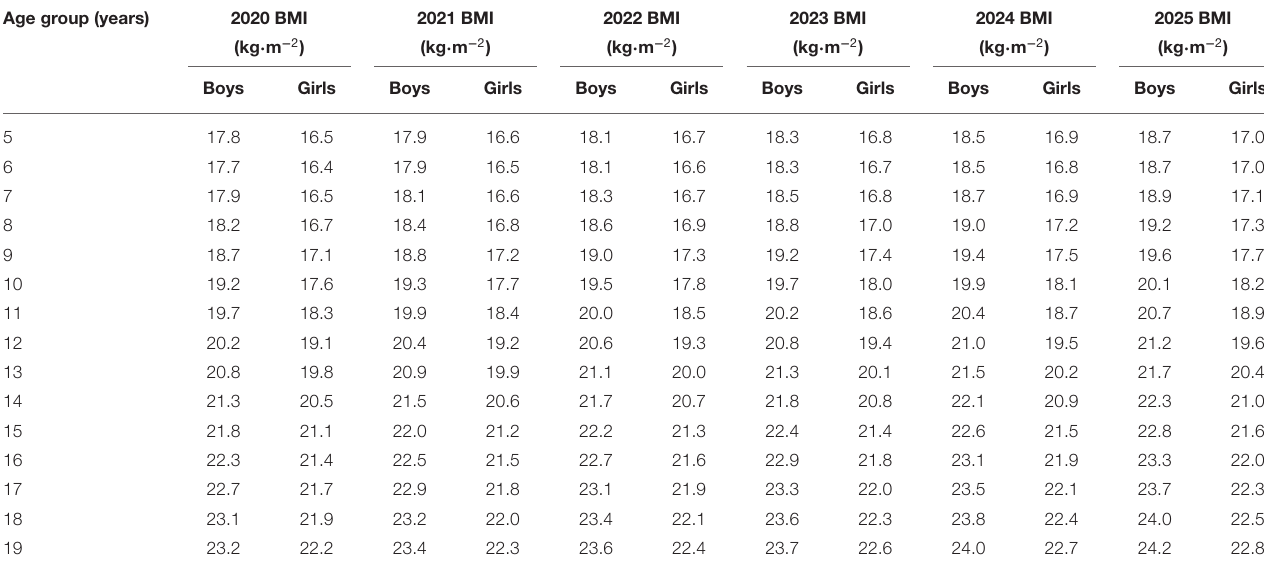
TABLE 1 | Projected mean body mass index of Chinese children and adolescents aged 5–19 between 2020 and 2025. Age group